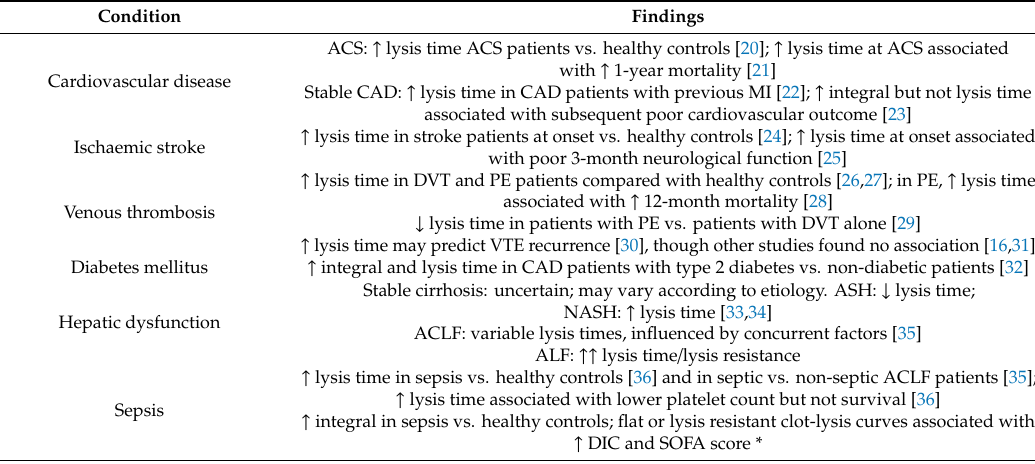
Table 4. The clot-lysis assay in clinical